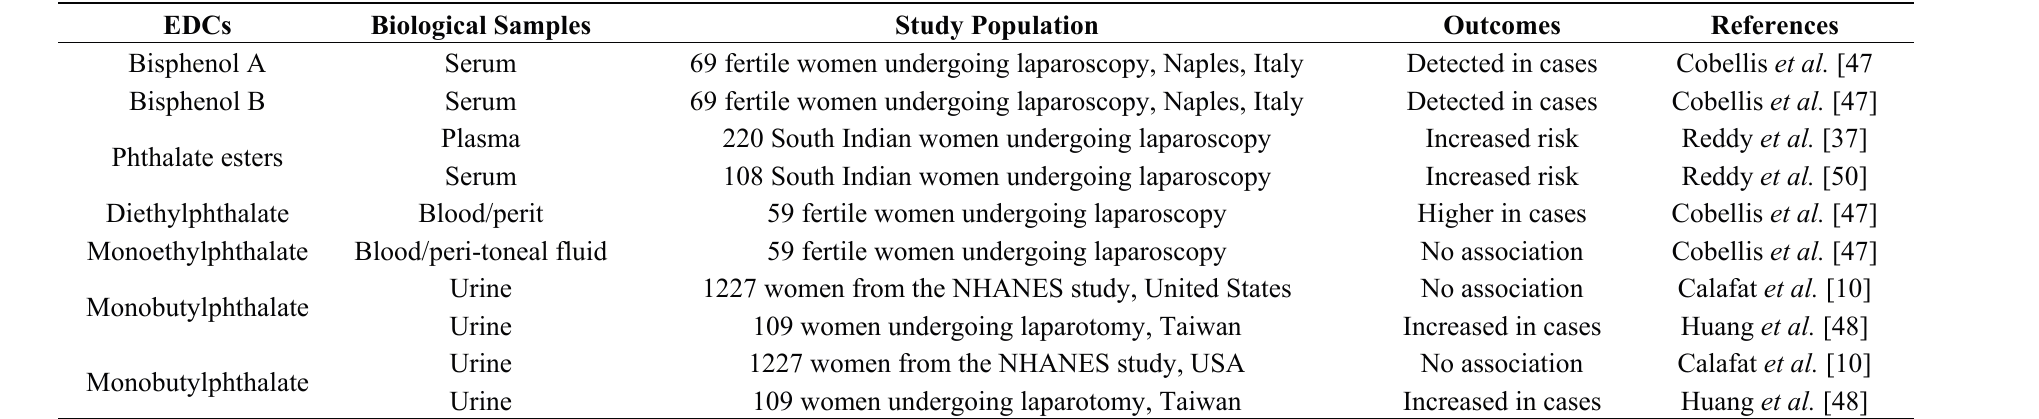
Table 5. Epidemiological studies of the association between EDCs-Phthalate or BPA and endometriosis.